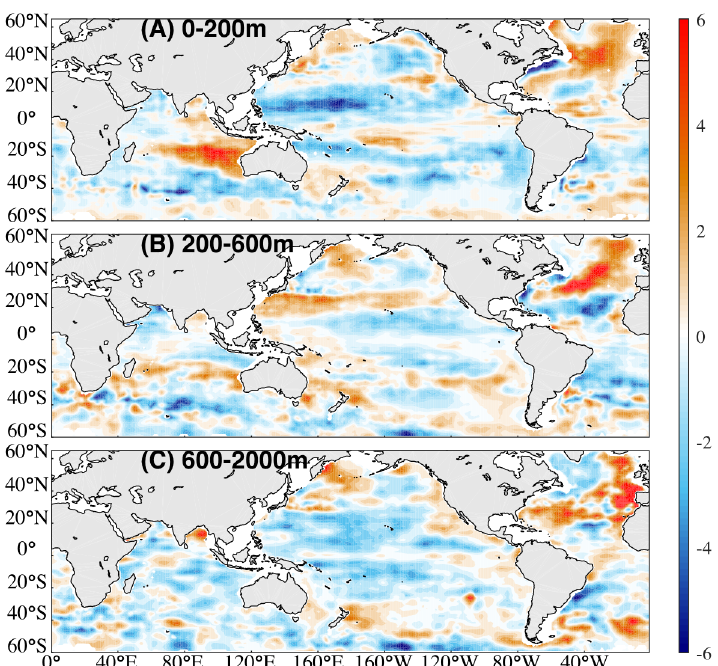
Figure 4. The spatial pattern of HSLA trend (Unit: mm/yr) in the upper 200-m layer ( A ); the 200 to 600-m layer ( B ); and the 600 to 2000-m layer ( C ), between 2005 and 2015. This is the ensemble mean of the SCRIPPS, JAMSTEC, EN4, and NCEI.